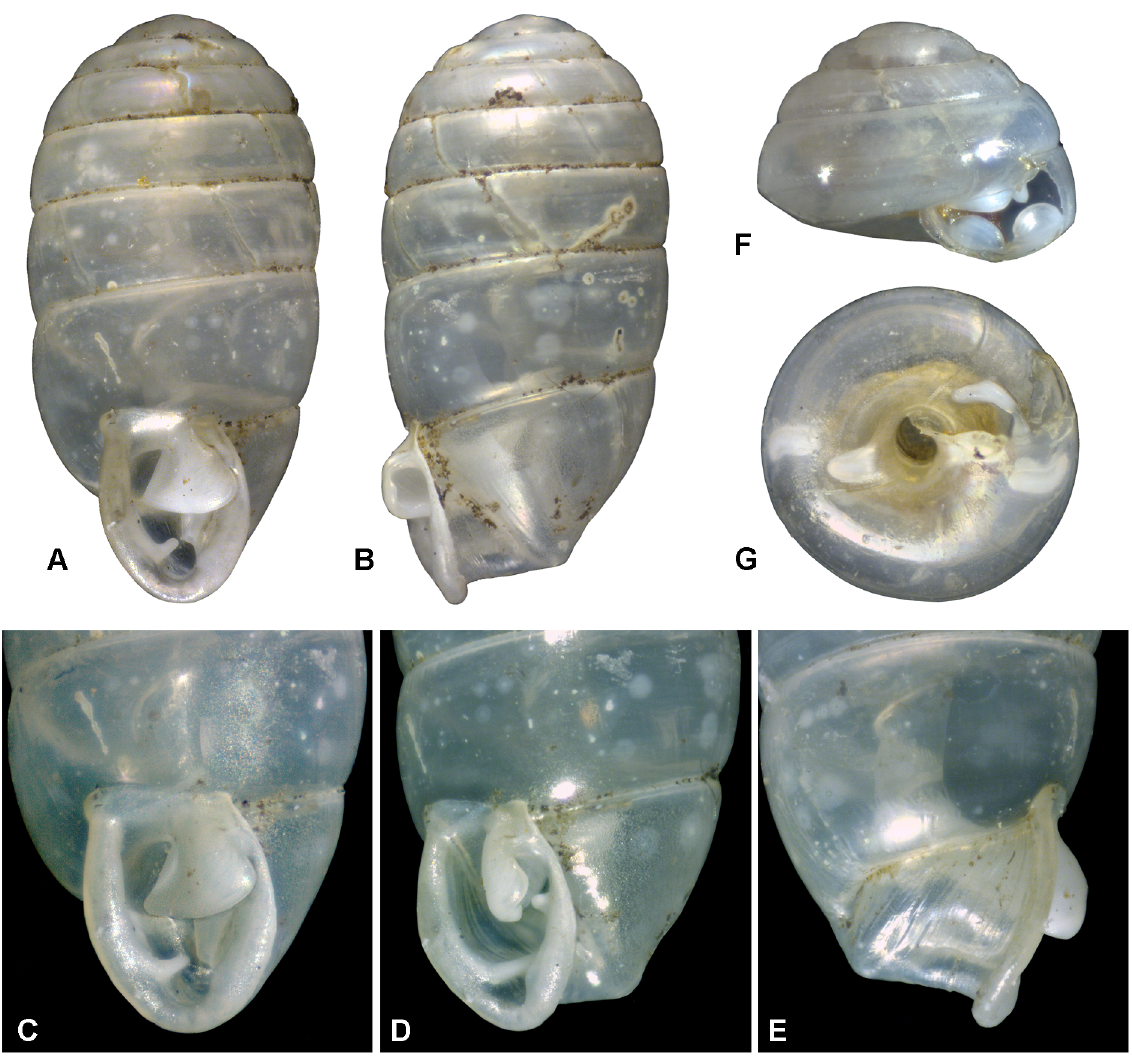
Fig. 3. Gulella hadroglossa sp. nov. A–E . Holotype, height 3.0 mm, diameter 1.5 mm (NMSA P0230/ T4084). F–G . Juvenile specimen showing apertural dentition, diameter 1.5 mm (paratype, NMSA